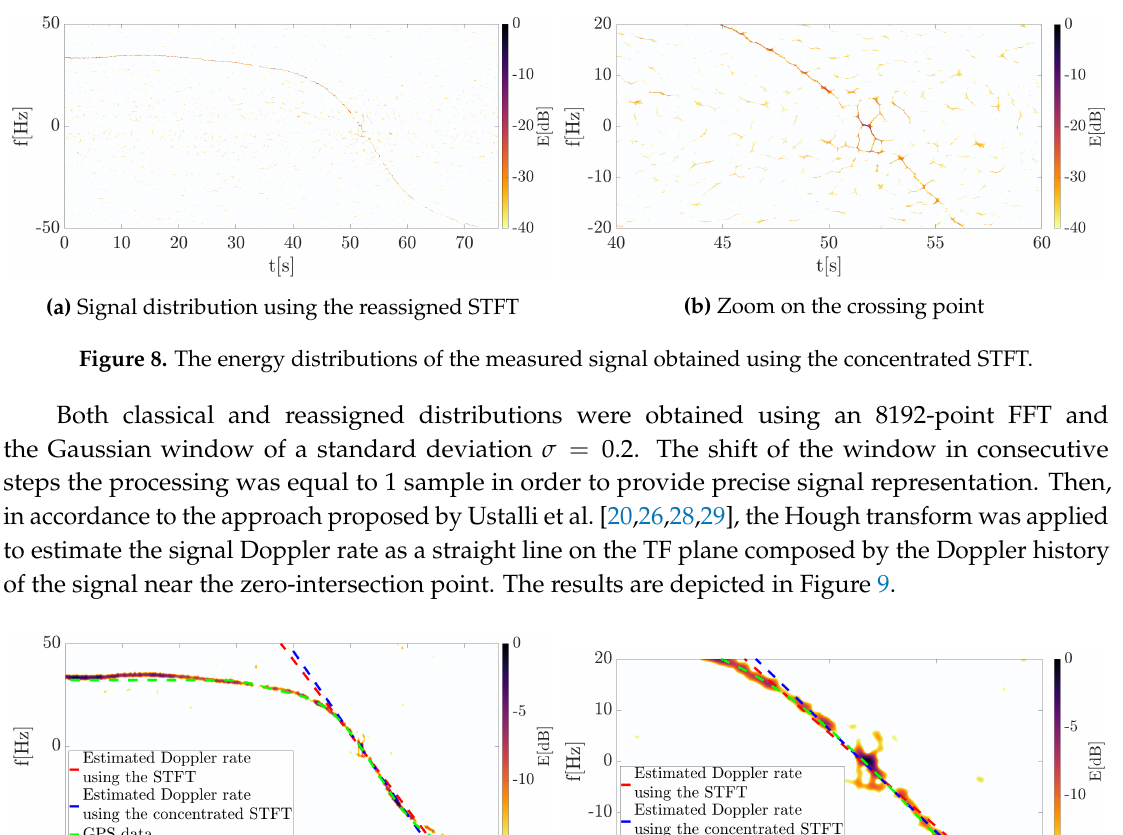
Figure 7. The energy distributions of the measured signal obtained using the classical STFT.